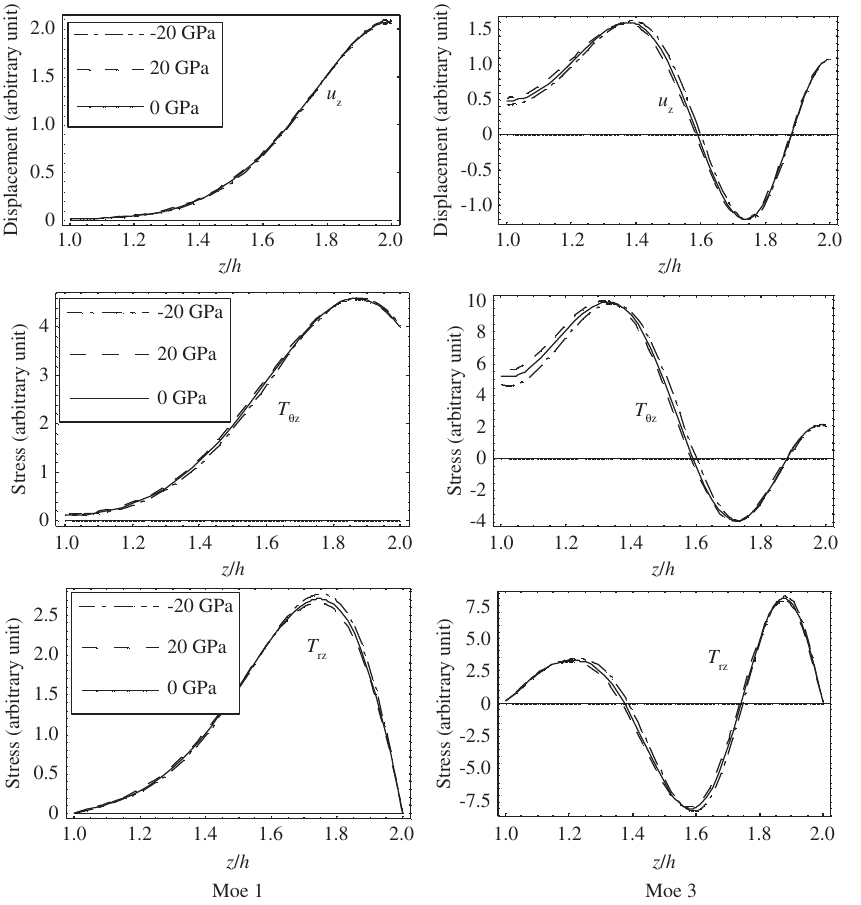
Figure 12 Displacement and stress distributions of circumferential SH wave for the linearly graded cylinder with η = 2 under different axial initial stress at kh =